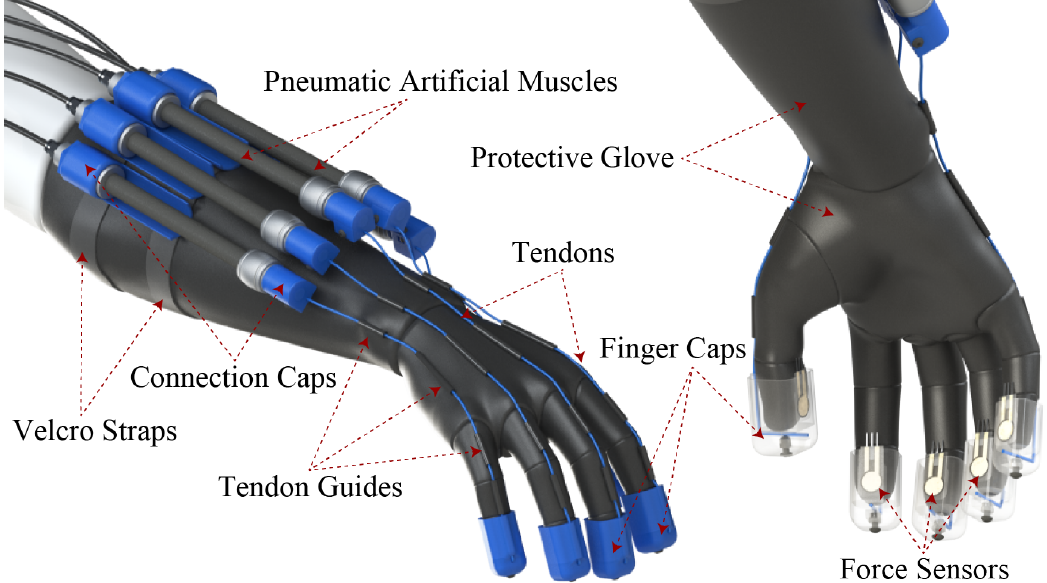
Figure 1. Overview of the exoskeletal glove base concept with highlighted main